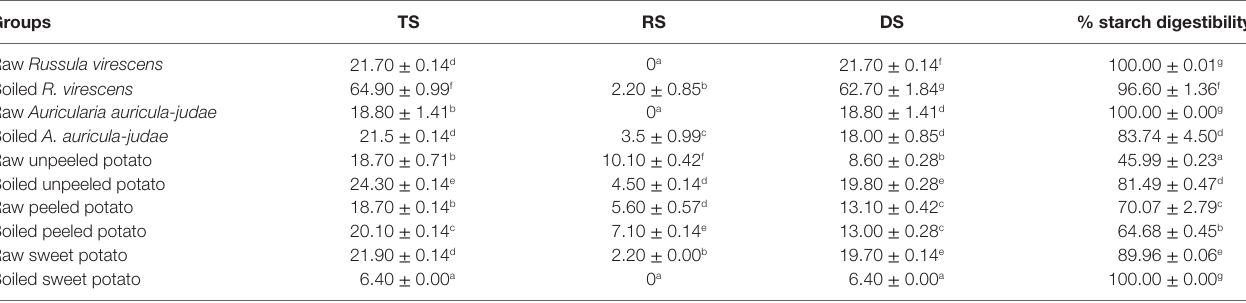
Values are means ± SD. a–g Means with different superscript letters along each column are significantly different (P < 0.05). TS, total starch; RS, resistant starch; DS, digestible starch; rapidly digestible